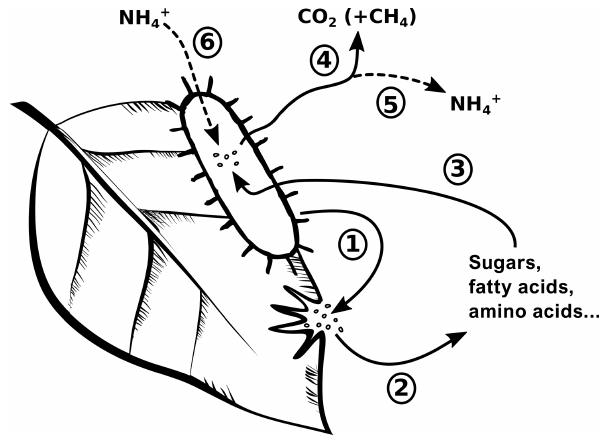
Figure 1. A conceptual view of carbon (C) cycling and nitrogen (N) cycling during litter decomposition. Microbial decomposers release exoenzymes (1), which depolymerize plant biopolymers to soluble monomers (2). The relative distribution of formed monomers de- pends on plant tissue composition and specific enzyme activities. Microbial decomposers assimilate the monomers (3) and either use the contained organic matter for growth or to obtain energy through mineralization (4). Microbial growth leads to an accumulation of microbial biomass within litter. N mineralization leads to a loss of ammonium to the environment (5), but this process is only active if amino acid–N supply (due to protein depolymerization) exceeds microbial N demand. Ammonium from the environment can addi- tionally serve to fulfill microbial N demand